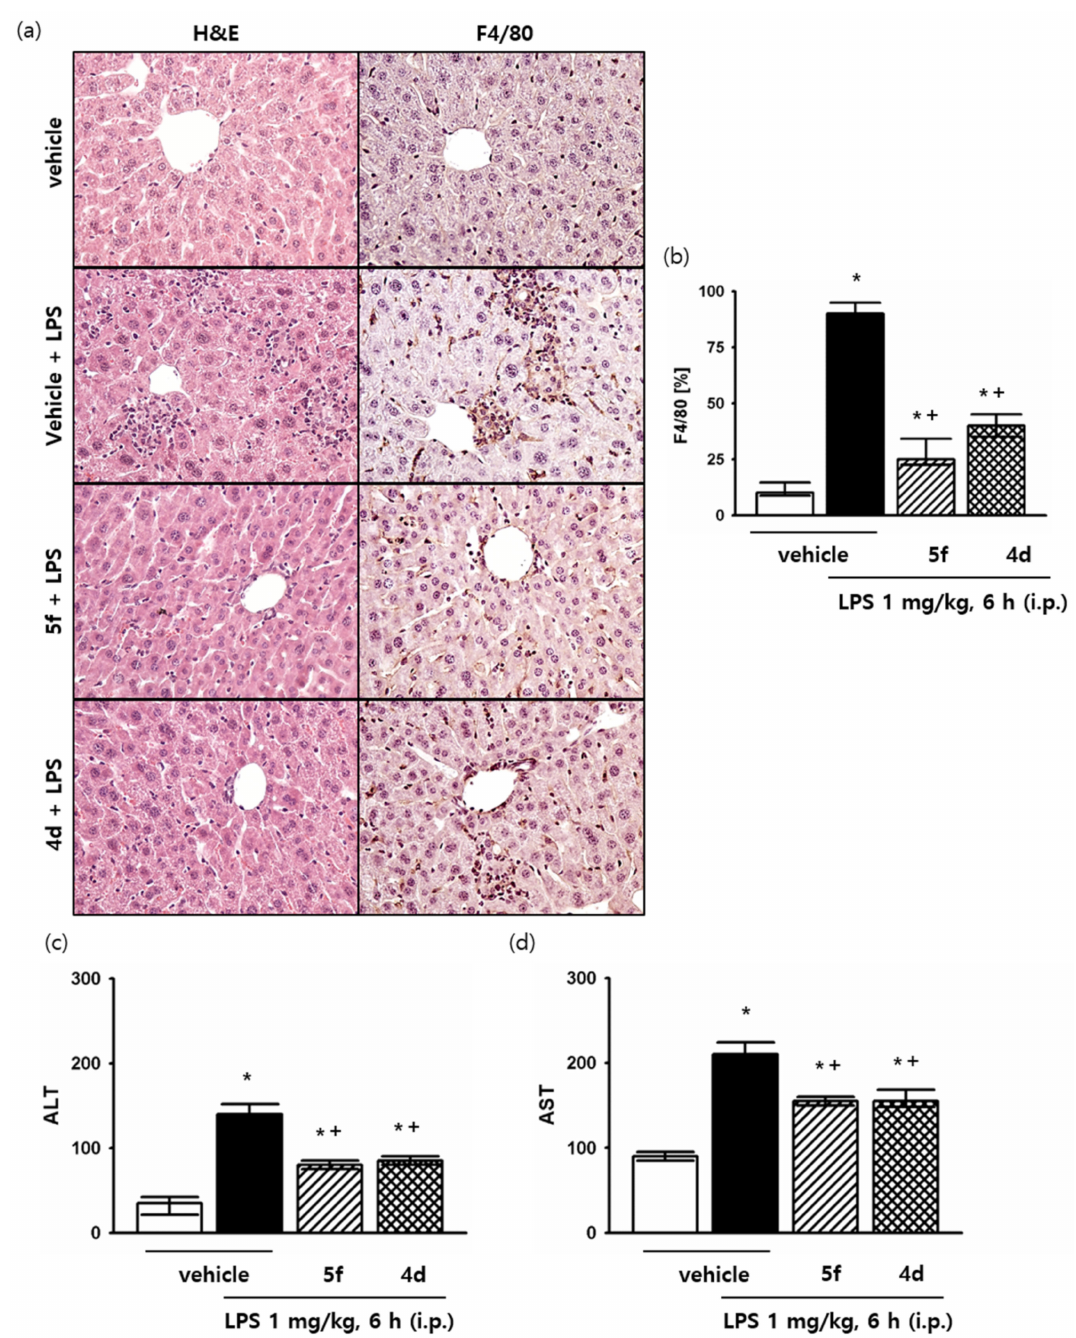
Figure 4. Protective effects of compounds 5f and 4d in vivo models for LPS induced-liver in- flammation disease. ( a , b ) Histopathological examination was performed using H&E staining and immunohistochemical staining using F4/80 antibody, the F4/80 positive areas were quantified, magnification are × 400. ( c , d ) Effects of compounds on serum ALT and AST levels during liver inflammation. * p < 0.05 compared with the group treated with the PBS (vehicle). + p < 0.05 compared with the group treated with the LPS. Data are presented as the mean ±